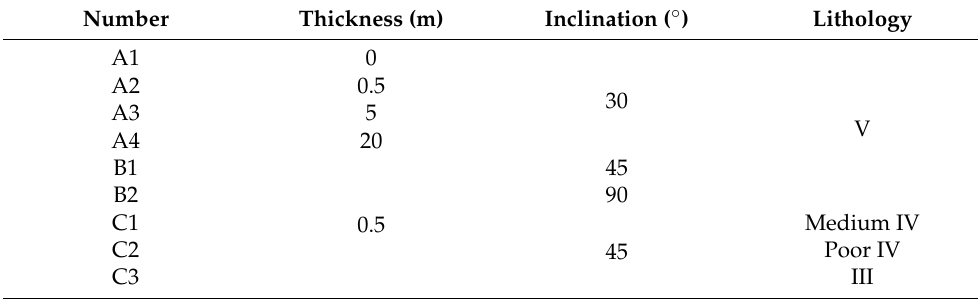
Table 2. Different adverse geological structure zones.